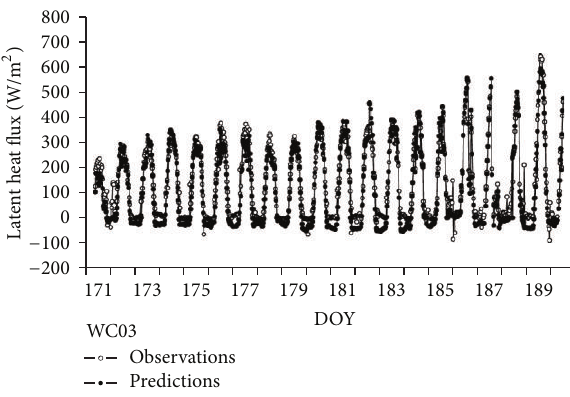
Figure 2: Comparison of observed (open circles) and predicted (solid dots) latent heat flux (W/m 2 ) for WC06. DOY denotes the day number of the year in 2002.